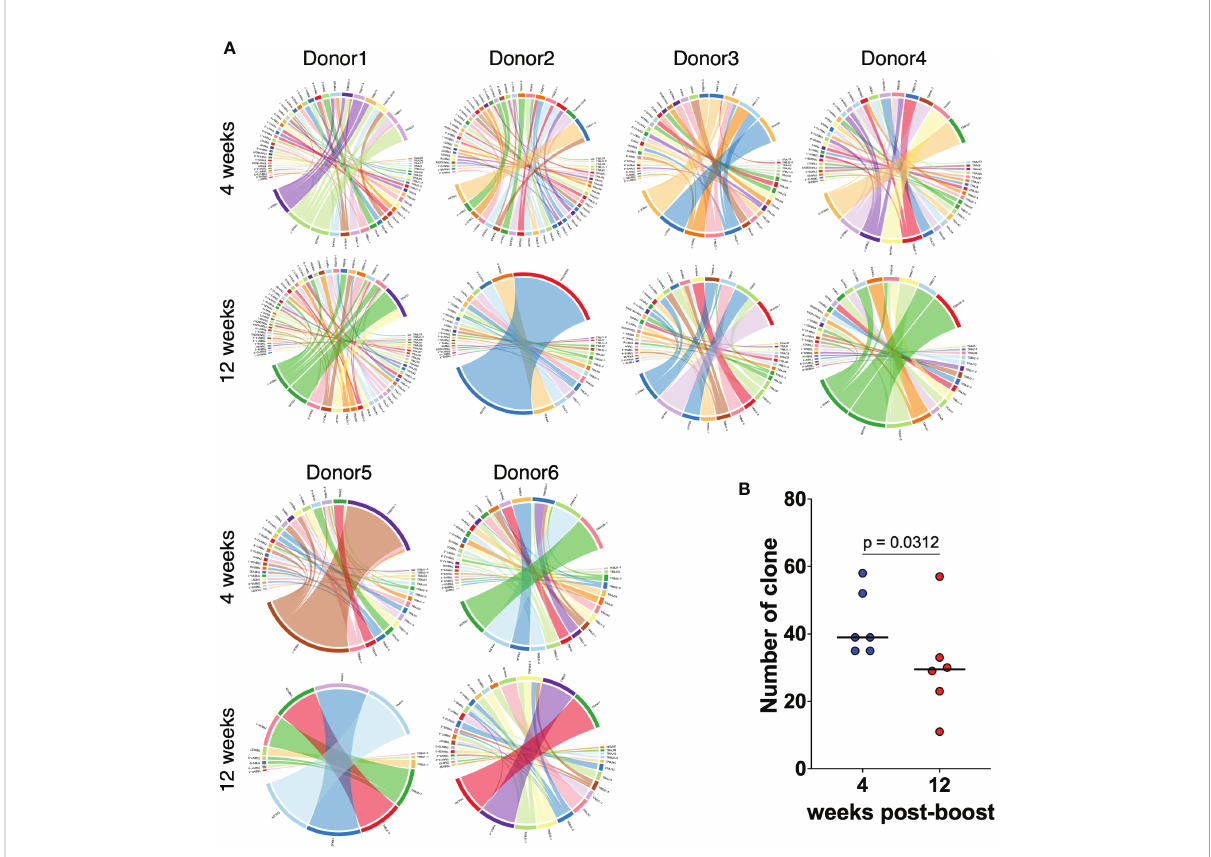
FIGURE 3 TCR repertoires of CD8 + T cells induced by mRNA vaccines decrease over time. (A) Circos plots representing the frequencies of V-J combinations in six vaccinated donors at 4 weeks and 12 weeks post second vaccination for SARS-CoV-2 WT-derived spike-speci fi c CD8 + T cells. (B) Dot plots representing the number of TCR clones as in (A) . P -values were calculated using the Wilcoxon matched-pairs signed rank